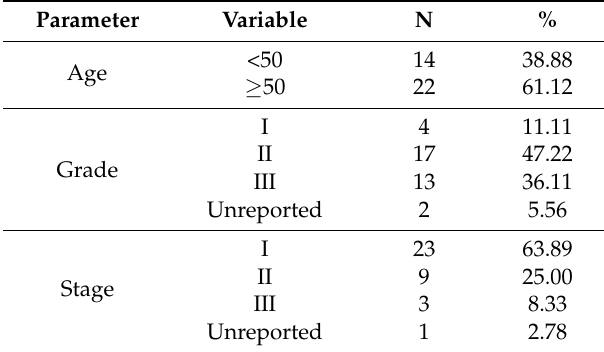
Table 1. Clinicopathological features of the 36 endometrial carcinoma cases investigated with immunohistochemistry.